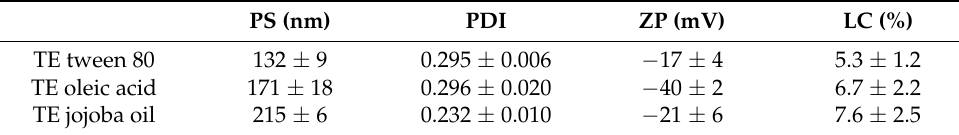
Table 2. Characterization of NIA loaded-TEs TE tween 80, II and